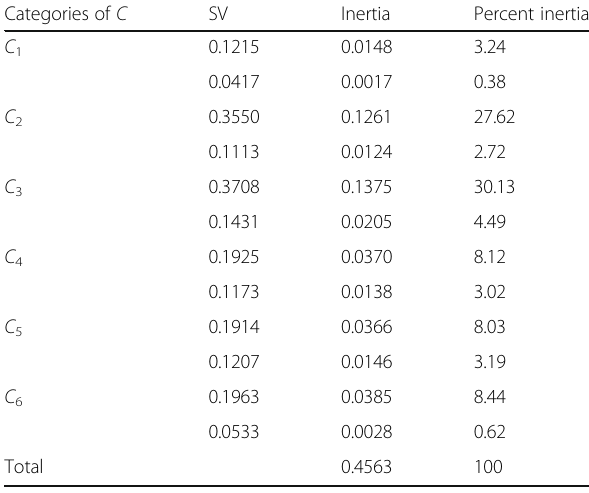
Table 3 Results of MCA based on separate SVDs for Table 2 along B and A across the categories of C Categories of